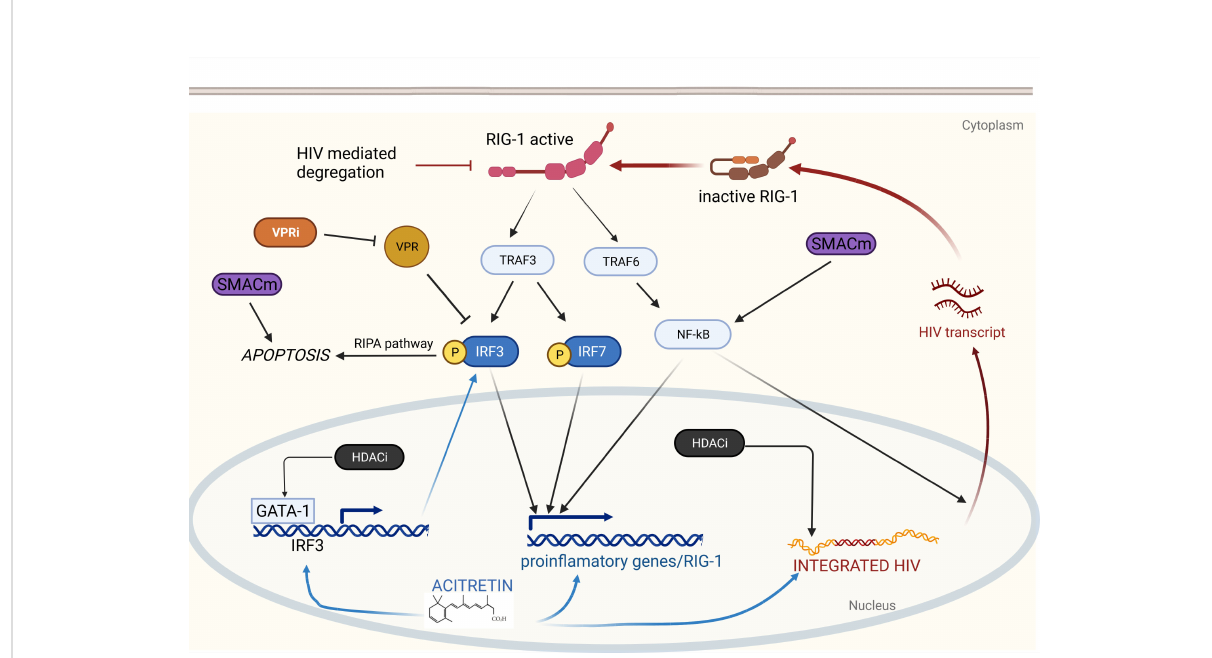
FIGURE 1 Retinoids induce HIV reactivation and enhance immunity via RIG-I. RIG-I detects intracellular HIV RNA resulting in TRAF3 and TRAF6 activation. TRAF6 elicits a signaling cascade releasing NF- k B which translocates to the nucleus and drives proin fl ammatory gene expression and HIV transcription. TRAF3 induces phosphorylation of IRF3 and IRF7 which also drive proin fl ammatory gene expression. Phosphorylated IRF3 can also induce apoptosis via the RIPA pathway. Acitretin enhances expression of IRF3, RIG-I, and proin fl ammatory genes as well as HIV transcription leading to reactivation of